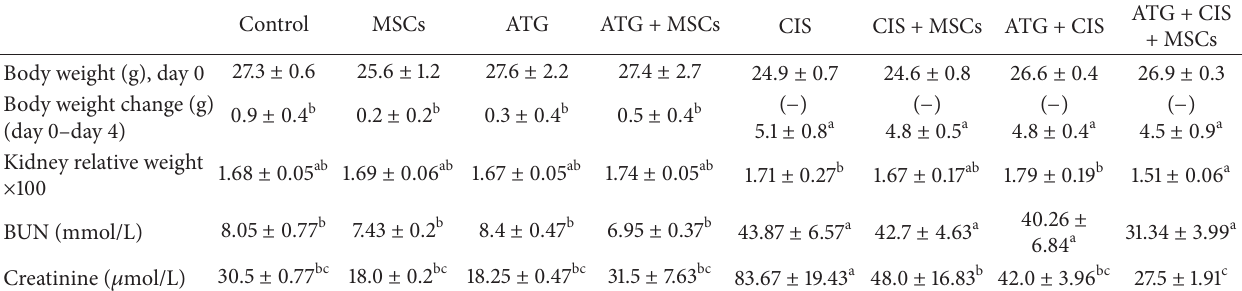
Table 3: Body weight, relative kidney weight, and renal function in BALB/cOlaHsd mice 4 days after cisplatin administration. Control MSCs ATG ATG + MSCs CIS CIS + MSCs ATG +